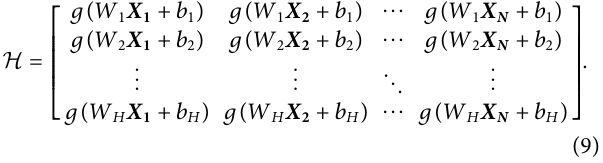
~ W (cid:2) ( α / Ψ ) W , ~ W